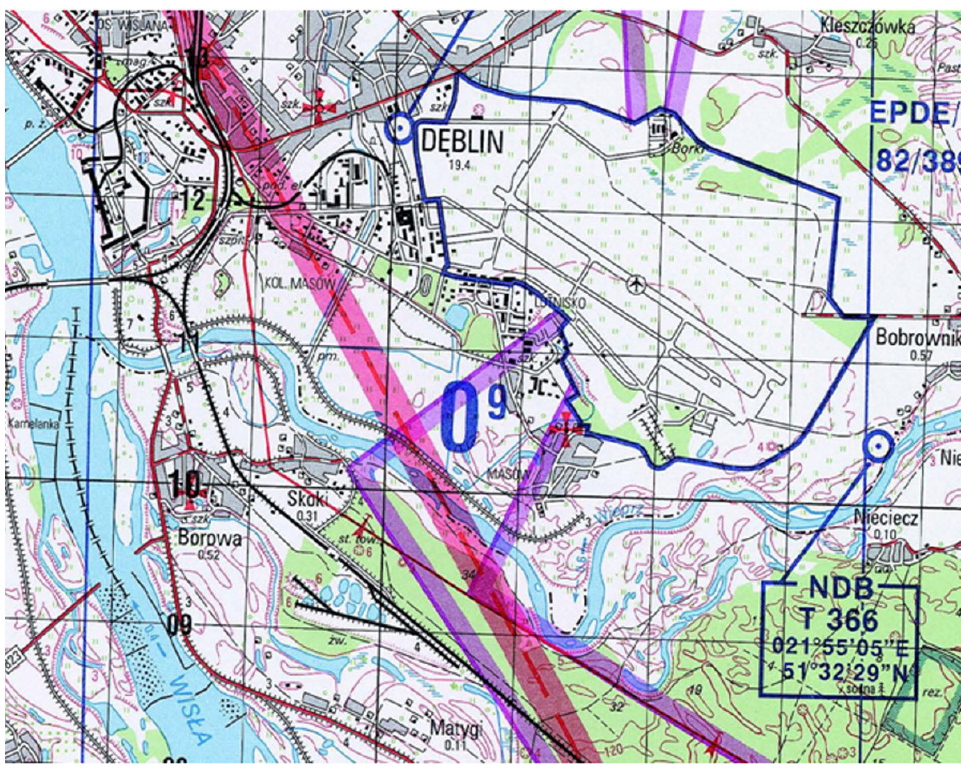
Fig. 18. Tactical Aeronautical Chart , 1:50,000 – M755-AIR